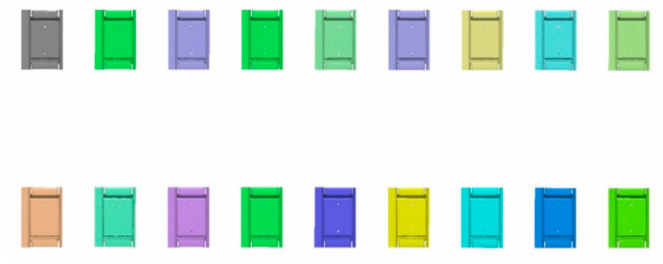
Figure 9. Point cloud splicing